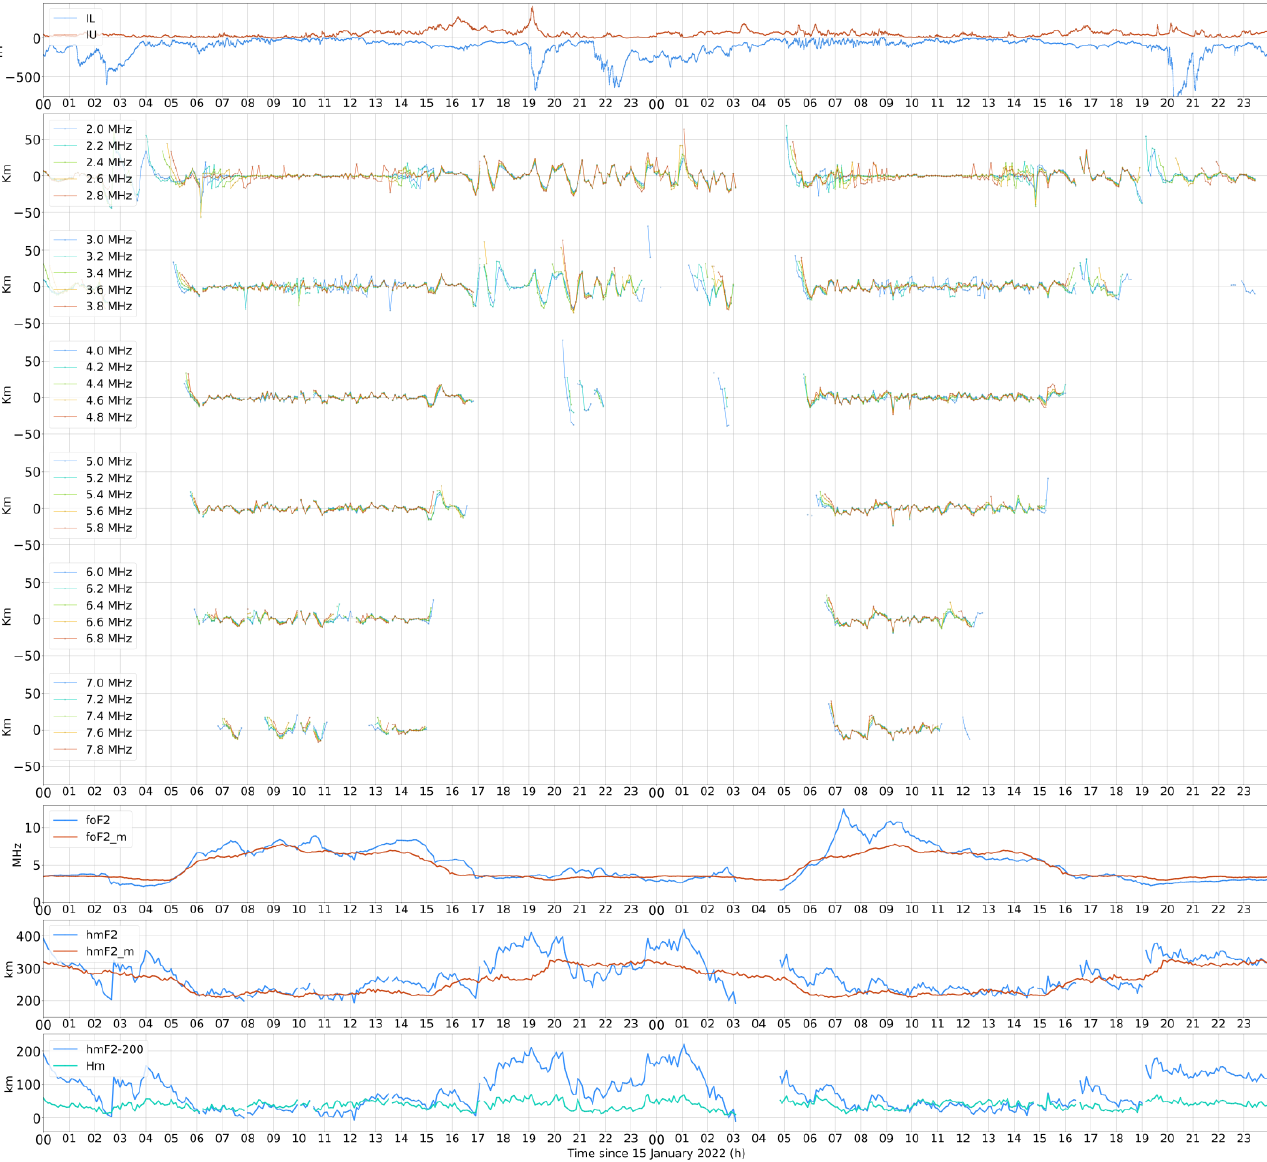
Figure 9. The IU and IL auroral electrojet indicators, together with the detrended height of iso-ionic densities and the variability of the ionospheric characteristics at the height of peak density over Athens for the time interval of 15–16 January 2022.